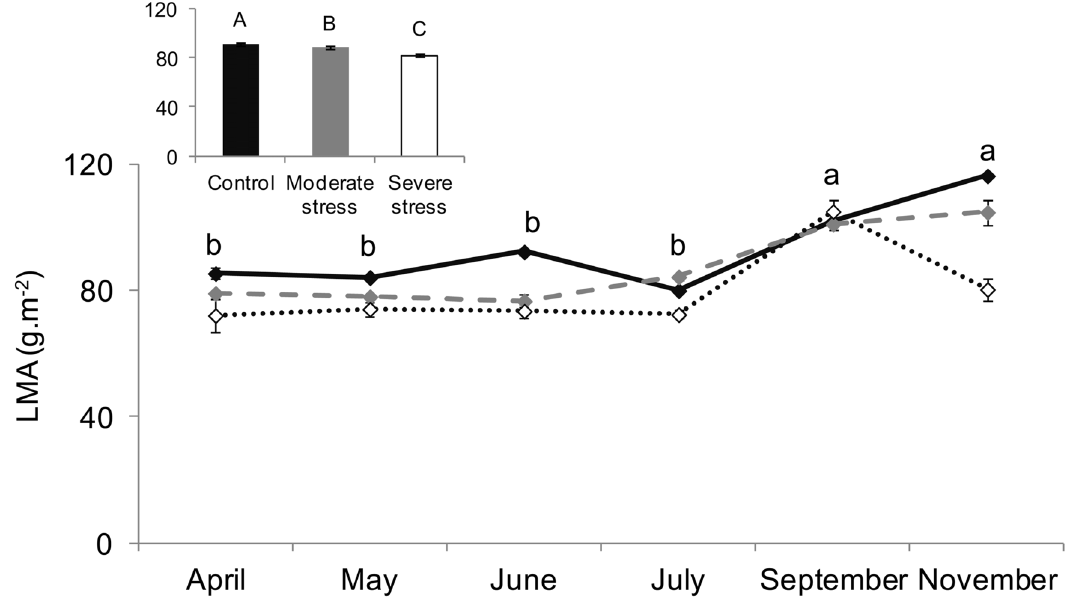
Figure 7. Mapping control, mild stress and severe stress. Two-dimensional mapping of the Principal Component Analysis (PCA) performed for all plant traits measured at the end of the experiment (plant growth, emission or concentration of secondary metabolites, gas exchange and water status). This analysis was performed on n=5 trees per treatment. Traits shown at the end of some arrows correspond to the most explanatory traits.